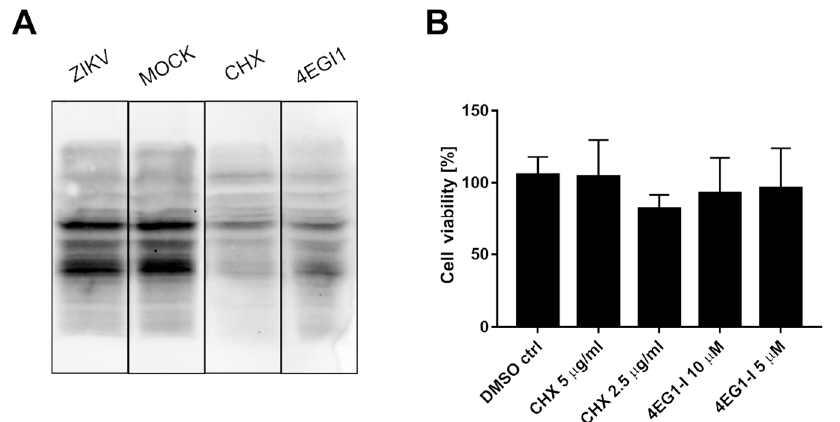
Figure 3. ZIKV infection does not inhibit the translation of host proteins. SUnSet assays were performed on ZIKV- and mock-infected A549 cells and cells treated with cycloheximide or 4EGI1 inhibitors. The presence of puromycin protein was detected using an anti-puromycin antibody ( A ). Cell viability was evaluated relative to control cells treated with DMSO alone. The assay was performed in triplicate, and average values with standard errors are presented ( B ).